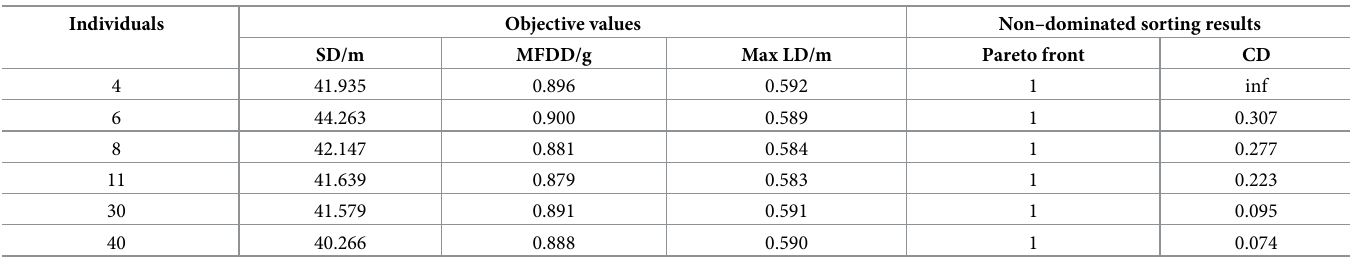
Table 9. Selected